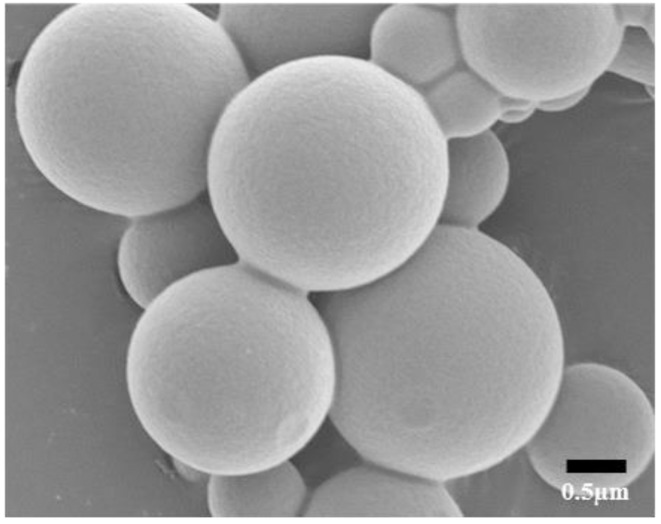
Scanning electron micrograph of DyDOTAM3+ containing RACs prepared at R = 0.5.